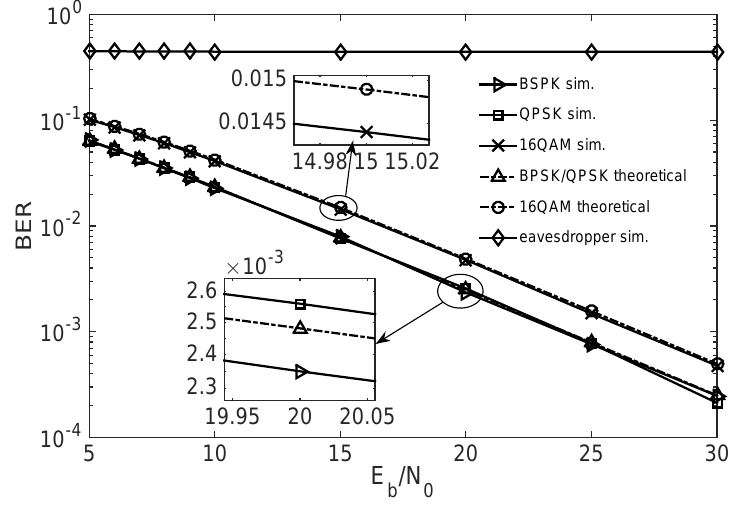
Figure 8. BER of the legal user and eavesdropper with various digital